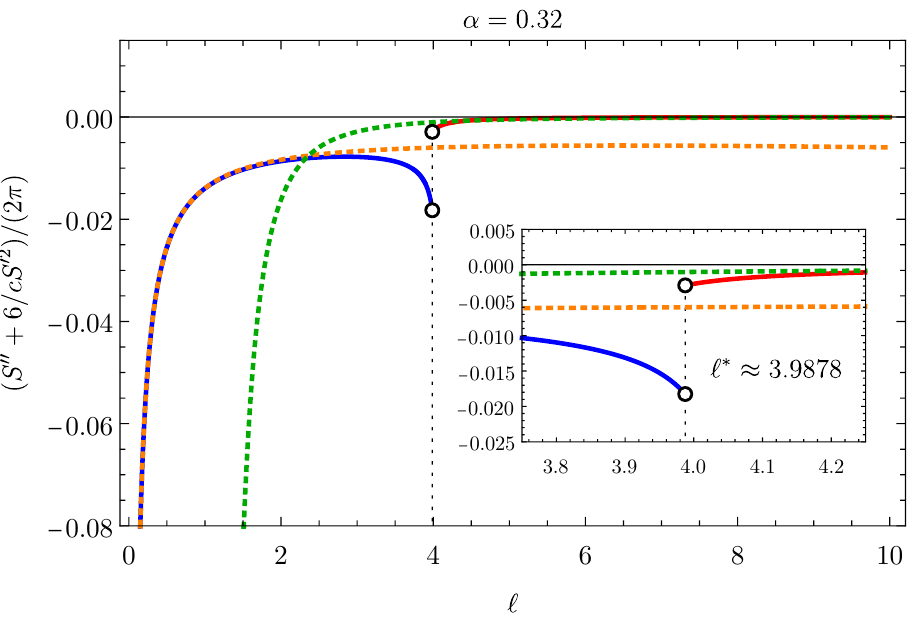
Figure 11 . QNEC 2 for the domain wall solution with α = 0 . 32 . Blue and red solid lines: numerical results for QNEC 2 in the small and large ‘ branches left and right of the critical interval ‘ ∗ . Orange and green dashed lines: perturbative results for small ‘ and large ‘ given in (6.1) and (6.3), respectively.